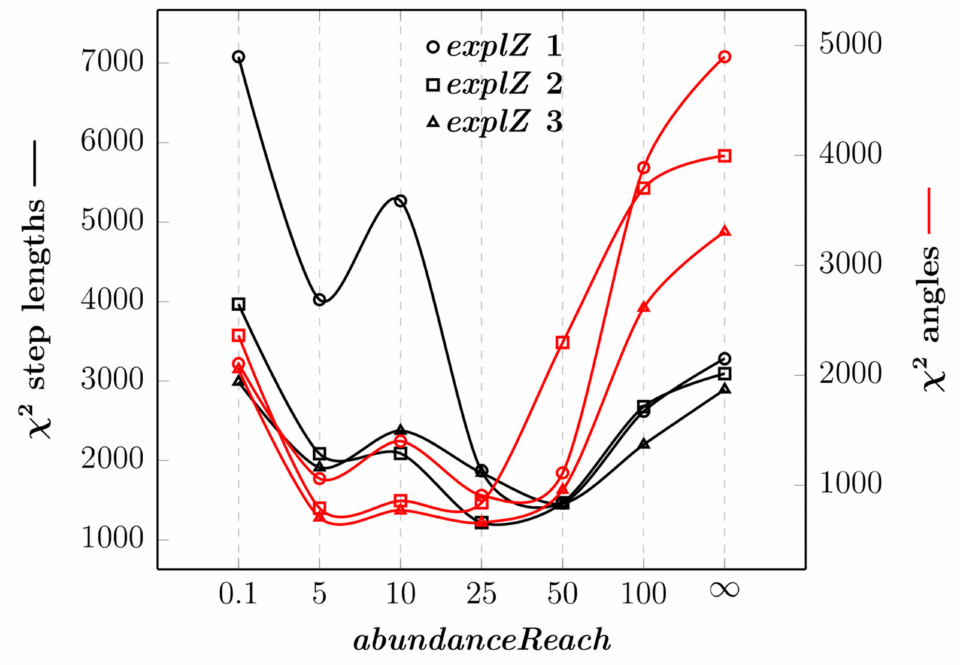
Figure 8. χ 2 for comparing step length and angle distributions between observed and simulated trajectories as a function of abundanceReach , for velocity = levyRatio = 1 and explorationZone = 1, 2 and 3. The black (resp. red) curves represent the χ 2 for step lengths (resp. angles) and are plotted along the left-hand (resp. right-hand) y-axis. For each simulation, the group of particles was simulated from the same starting point on a map of high food availability in the dry evergreen